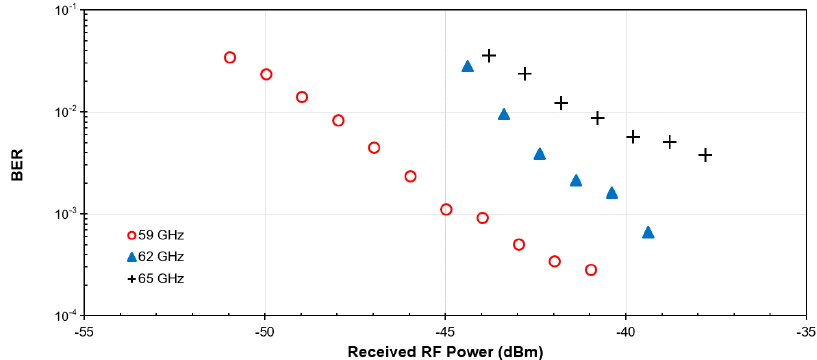
Figure 12. Measured BER over received RF power for three simultaneously transmit 1 Gbit/s OOK data signals at radio frequencies of 59 GHz (circles, red) 62 GHz (triangles, blue) and 65 GHz (crosses, black).